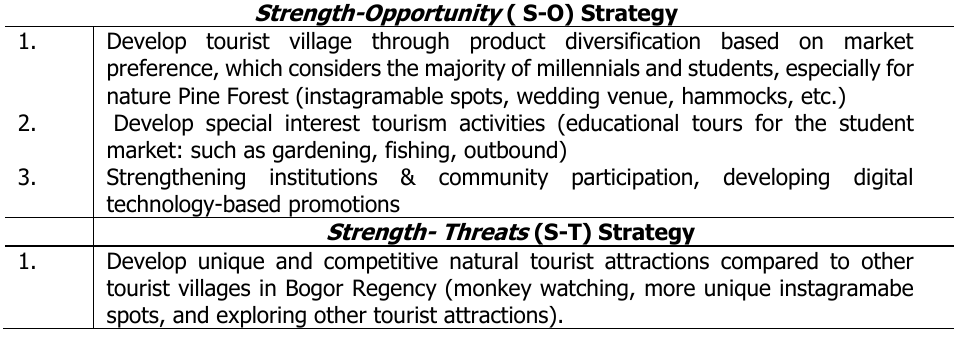
Table 5. Sukajadi Tourism Village Development